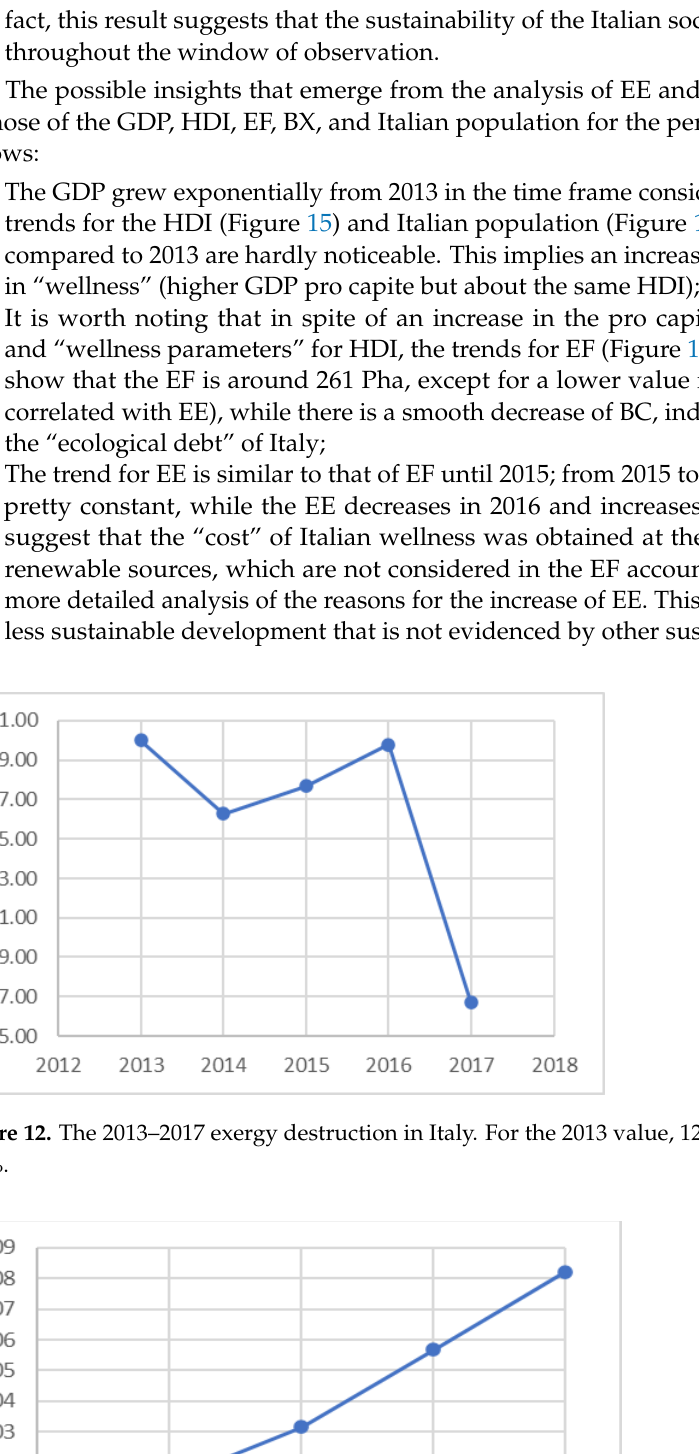
Figure 14. Extended exergy from 2013 to 2017. The 2013 value (1331917.46) is set to 100%.